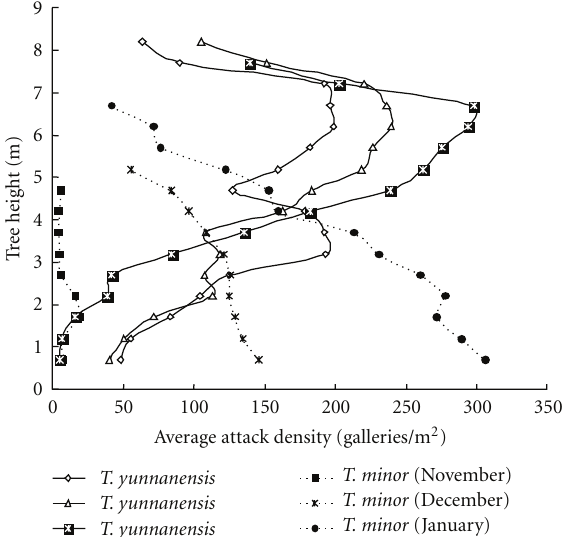
Figure 4: Progression of average attack (egg gallery) density and distribution of T. yunnanensis and T. minor along the trunks of Yunnan pines from November to January, 2005-2006 (Qujing, Yunnan province, China).